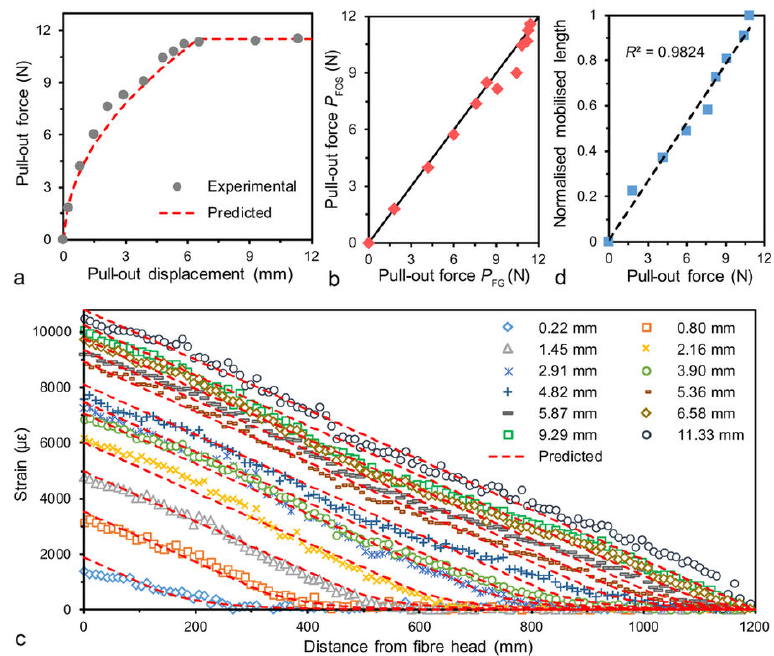
Figure 14. Results of pull-out experiments carried out by Zhang et al. [186]: ( a ) pull-out force vs. pull-out displacement; ( b ) pull-out force measured by fibre vs. load cell; ( c ) strain along the fibre vs. pull-out displacement; ( d ) pull-out force vs. percentage of the fibre detached from the